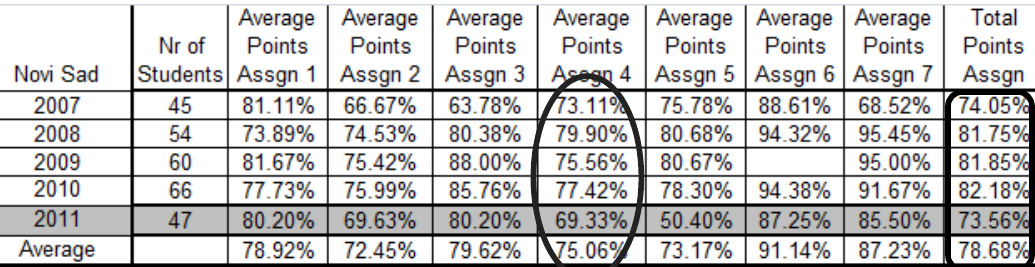
Assignment Points for Novi Sad Students of Computer